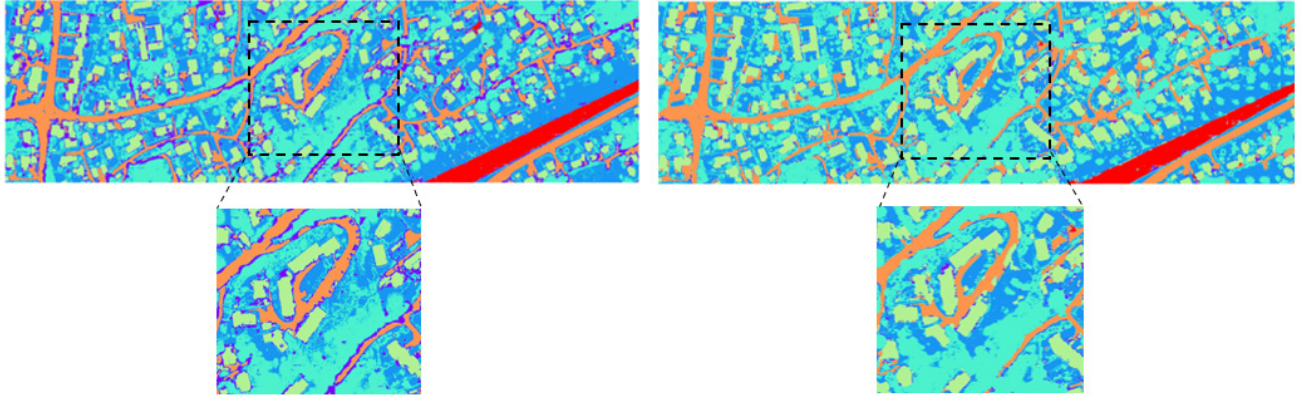
Figure 7. Segmentation results without data augmentation for the dataset from 2019 and 2021 for the ResU-Net showing ( a ) the first segmentation iteration for the dataset from 2019, ( b ) the first segmentation iteration for the dataset from 2021, ( c ) the second segmentation iteration for the dataset from 2019, and ( d ) the second segmentation iteration for the dataset from 2021.